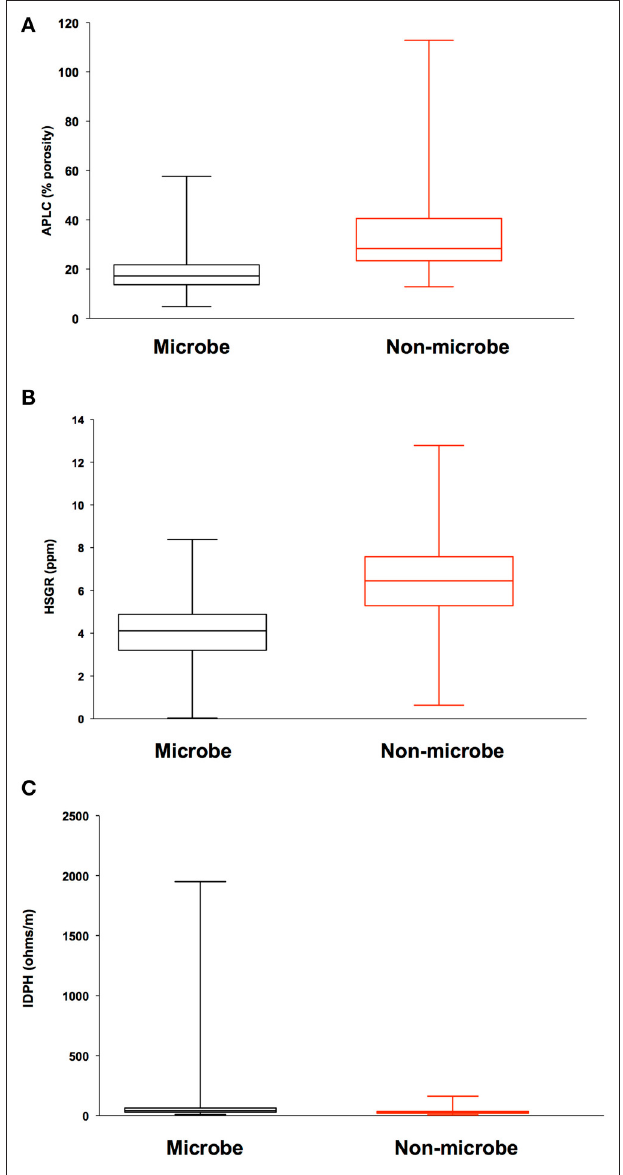
FIGURE 5 | Iterative Non-hierarchical Cluster Analysis (INCA) indicates no relationship between the structure of the detected microbial signatures and the lithological properties within 395A. Briefly, INCA is a variation on K-means clustering, in which objects are moved into and out of clusters, the number of which has been defined by the user (Harvey et al., in prep). The objective is to minimize the variability within clusters, while maximizing the variability between clusters. Resistivity, porosity, and gamma ray profiles for 395A were compared to the distribution of microbial signatures to determine if there was a relationship between the shape of the microbial data and the lithology of 395A. Results from INCA indicate no relationship between the observed structure of the microbial signals, and the lithology of 395A. Data are presented as box and whisker plots for simplicity, and indicate overlap with all physical properties data between the two categories (microbe and non-microbe) used in the analysis. (A) Accelerator porosity sonde; provides porosity information for the borehole wall; (B) hostile natural gamma ray sonde; used to provide information on lithology, e.g., rock vs. clay; (C) dual induction resistivity tool; provides spontaneous potential data that can be used to elucidate density, porosity, and lithologic